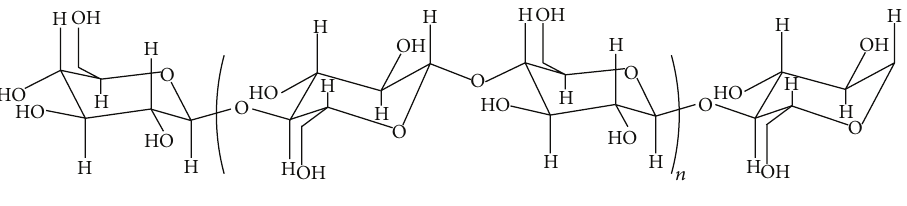
Scheme 2: Structure of cellulose.